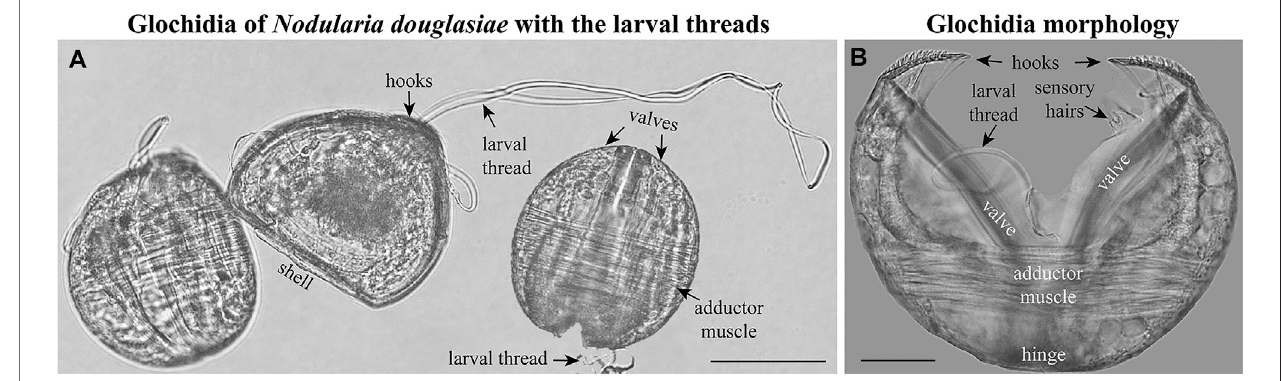
FIGURE2| Glochidiaof Nodulariadouglasiae. (A) Matureglochidiaof N.douglasiae withthelarvalthreads. (B) Glochidiumwithopenvalves.Largestyliformhooks, adductor muscle, and bundles of sensory hairs (under the hooks), partly the larval thread, are visible. Light microscopy. Collection: Amur River basin. Scale bars, (A) , 100 μ m; (B) , 50 μ